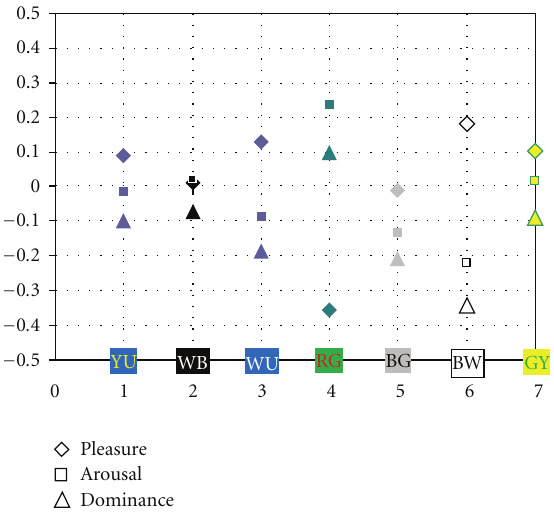
Figure 6: The mean values of each color combination for “Pleasure”, “Arousal”, and “Dominance”. The code numbers in X - axis are 1 for Yellow on Blue, 2 for White on Black, 3 for White on Blue, 4 for Red on Green, 5 for Black on Gray, 6 for Black on White, and 7 for Green on Yellow.